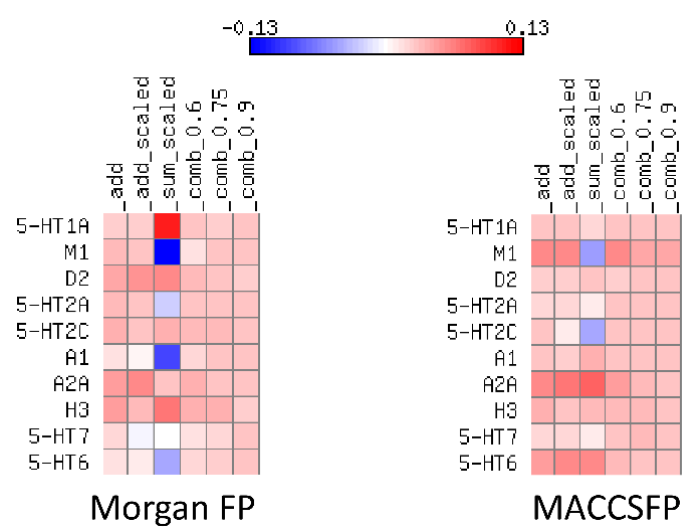
Figure 5. Heat maps presenting differences in precision at top 10% between approaches that take into account uncertainty and baseline for BAC splitting for 10 targets from benchmark studies.